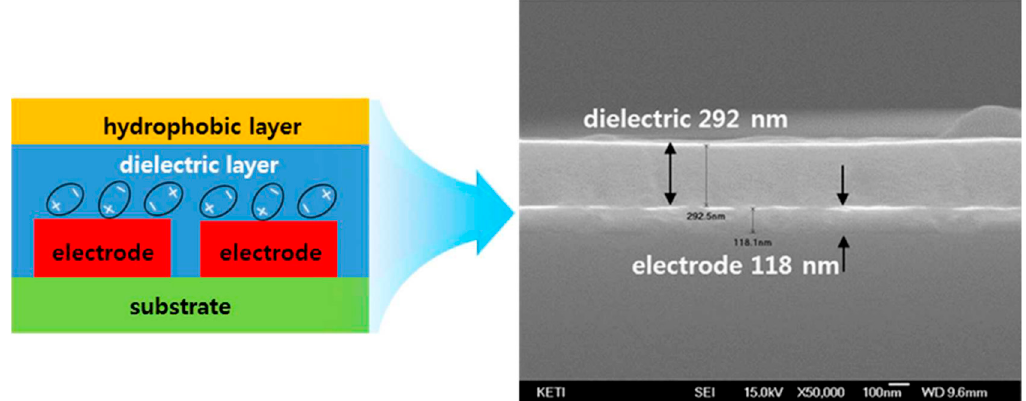
Figure 2. Schematic design and cross-sectional SEM image of the rain drop counting measurement sensor using WMAT